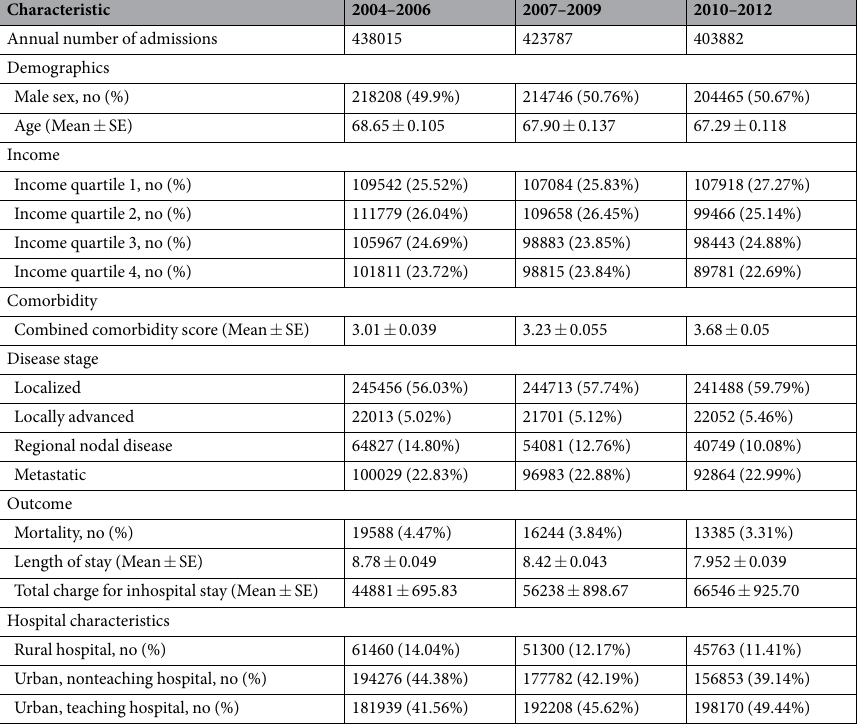
Table 1. Characteristics of the study cohort over three time